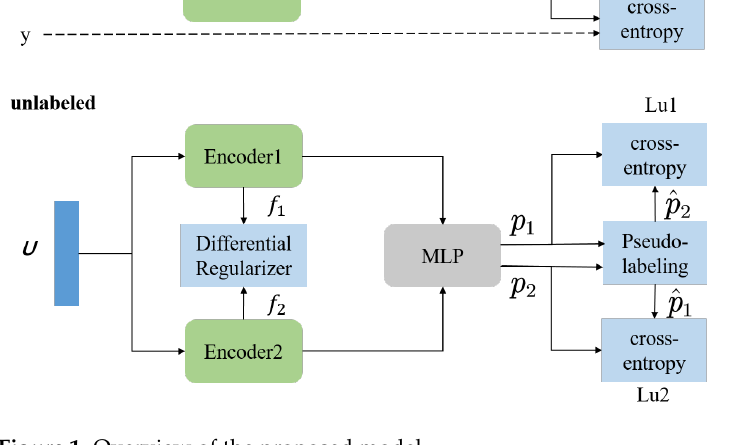
Figure 1. Overview of the proposed model.